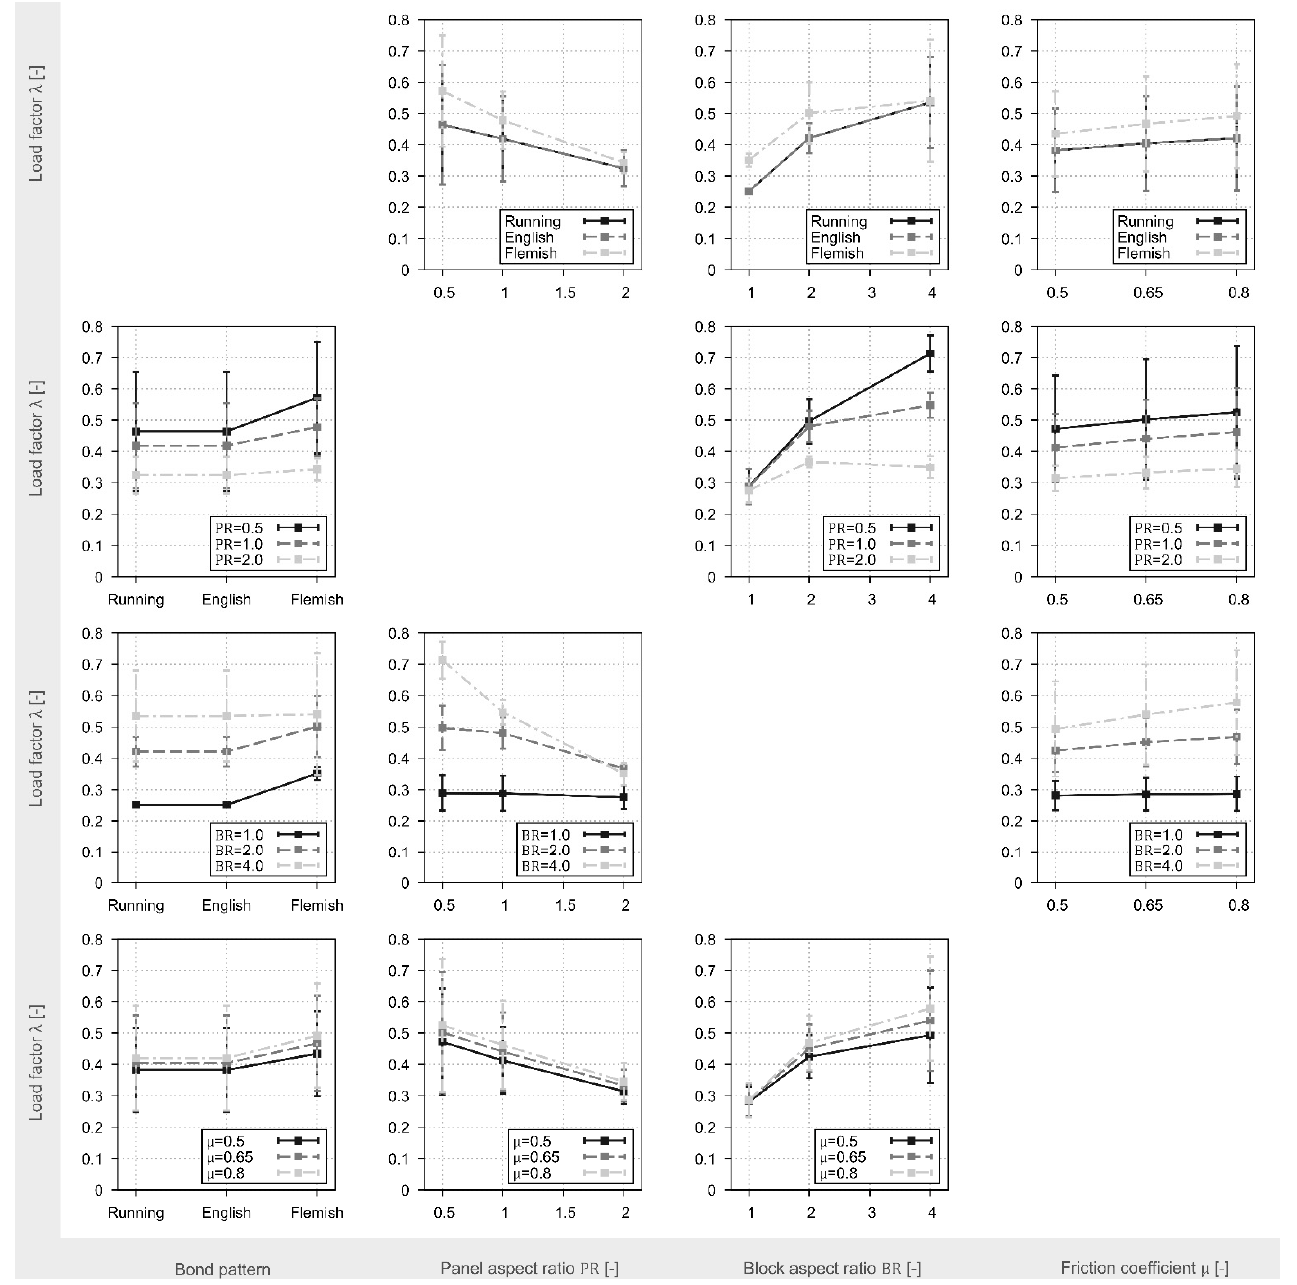
Figure 4. Two-way interaction plots: macro LA.